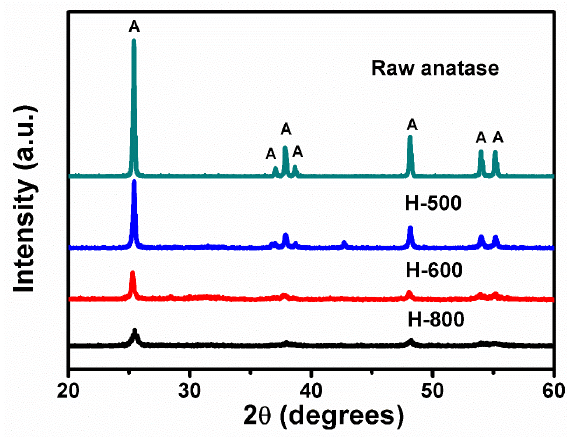
Figure 1. Influence of ball-milling speed on the crystalline structure (A: anatase TiO 2 ,